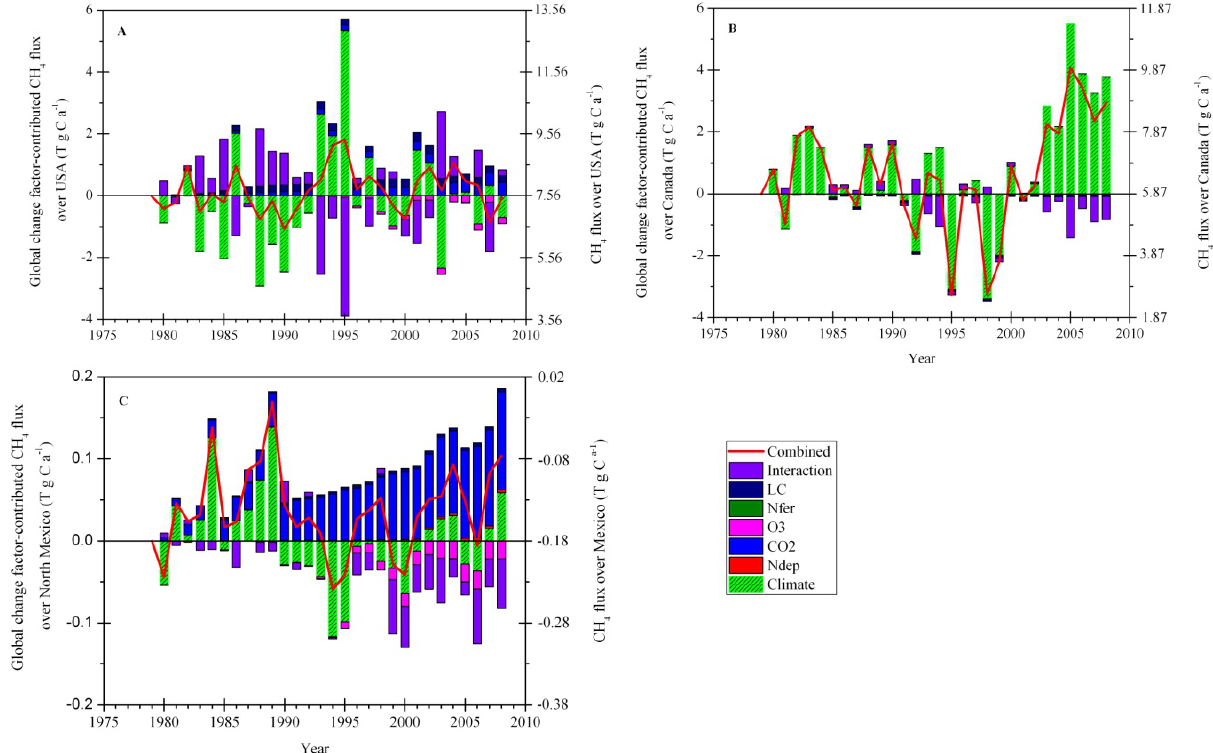
Fig. 9. Factorial contribution to the inter-annual variations in CH 4 flux by country ( (A) : USA; (B) : Canada; (C) : Mexico) (The right Y-axis shows the accumulated CH 4 flux with baseline; Interaction means contribution from multiple-factor interaction; LC means contribution from land conversion; Nfer means contribution from N fertilizer application; O 3 means contribution from O 3 pollution; CO 2 means contribution from elevated atmospheric CO 2 ; Ndep means contribution from N deposition; Climate means contribution from climate variability) 7